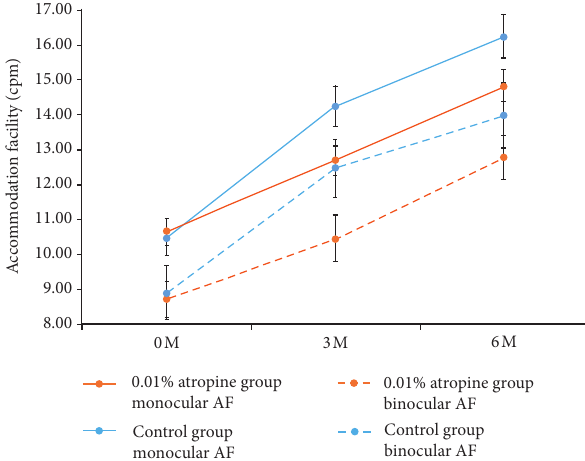
Figure 3: Mean and SE of AF in the atropine and control groups at baseline and follow-up visits. There was significant difference in both monocular and binocular AF between the two groups at 3- month visit. SE � standard error; AF � accommodation facility; cpm � cycles per minute.